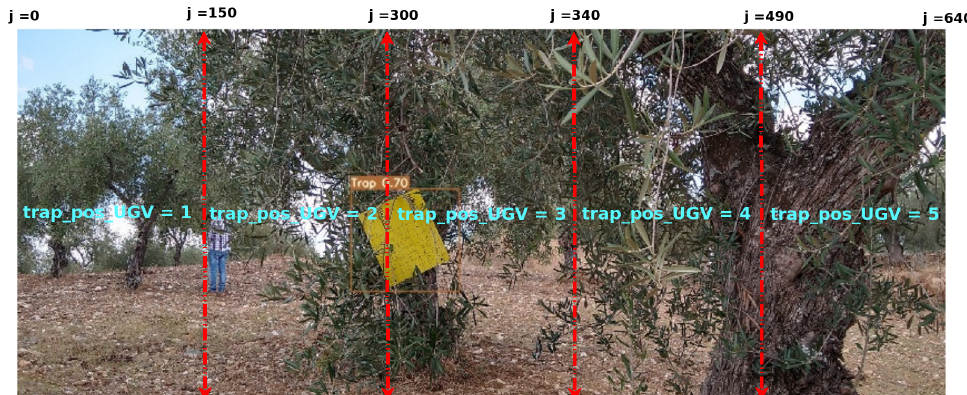
Figure 7. Splits in the image made for the detection of trap _ pos _ UGV . This value is informed to the UAS to start the trap search